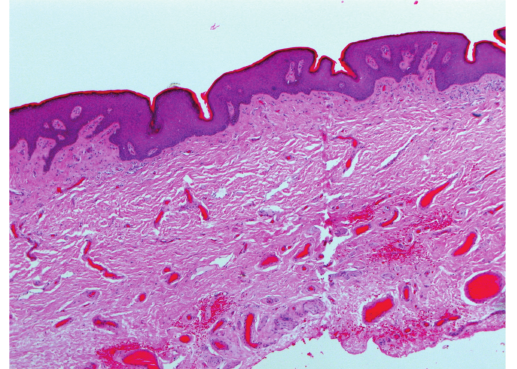
Figure 3: Histopathological picture confirms the diagnosis of pe- nile epidermal inclusion